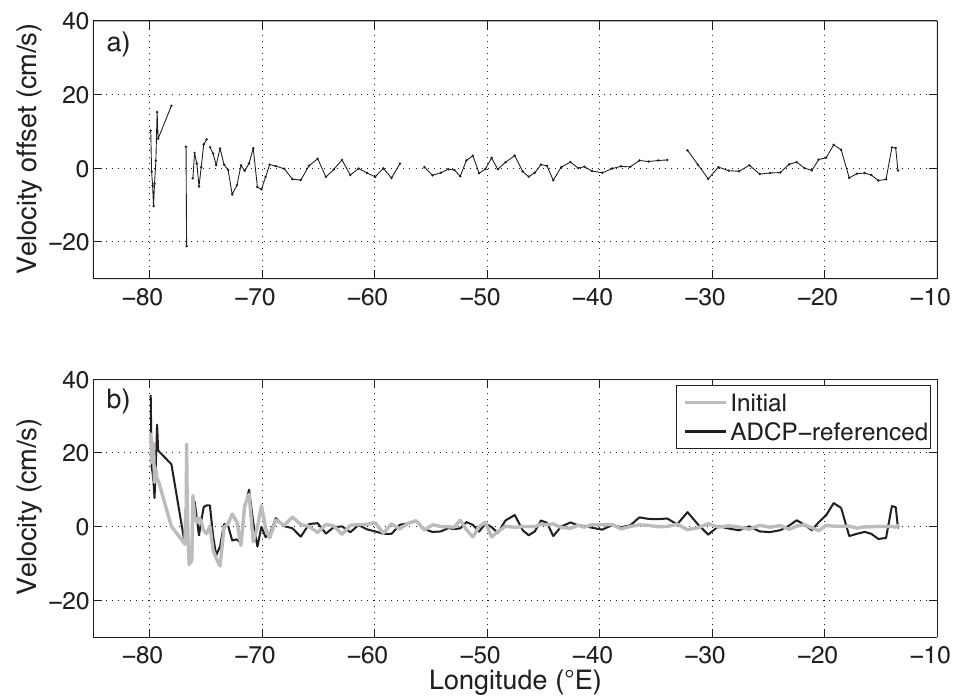
Fig . 5. – Comparison between the initial geostrophic profile and the ADCP-referenced for station pair #22-23 (located at 26.5°N, at 76.1°W and 75.9°W respectively). The dashed line represents the initial calculation while the solid one is corrected using ADCP data. Red and blue triangles correspond to bottom track records of Stations 22 and 23 respectively. Green triangles show the SADCP velocity calculated as the mean of the measurements taken during each cast. Note that the vertical scale is different for each depth range.